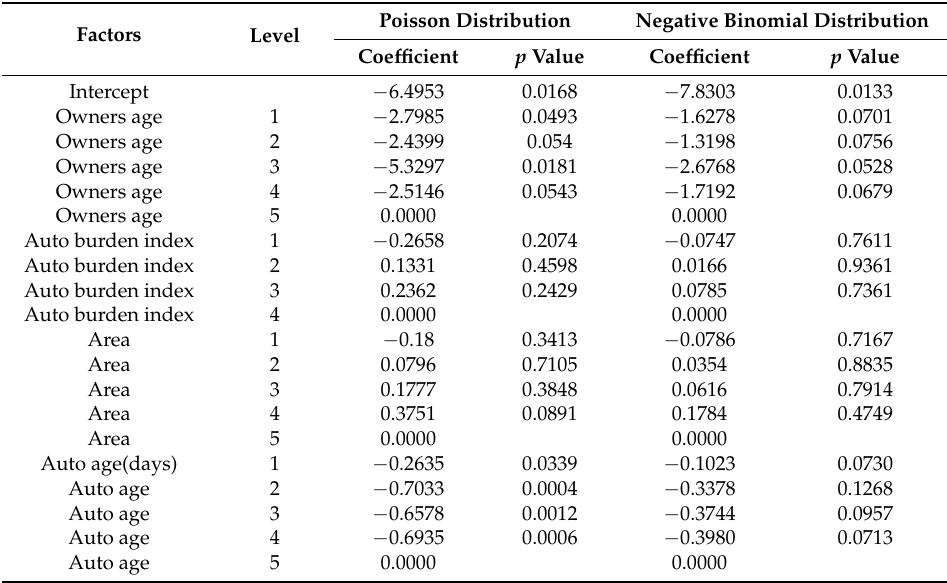
Table 5. The claim frequency fitted by two